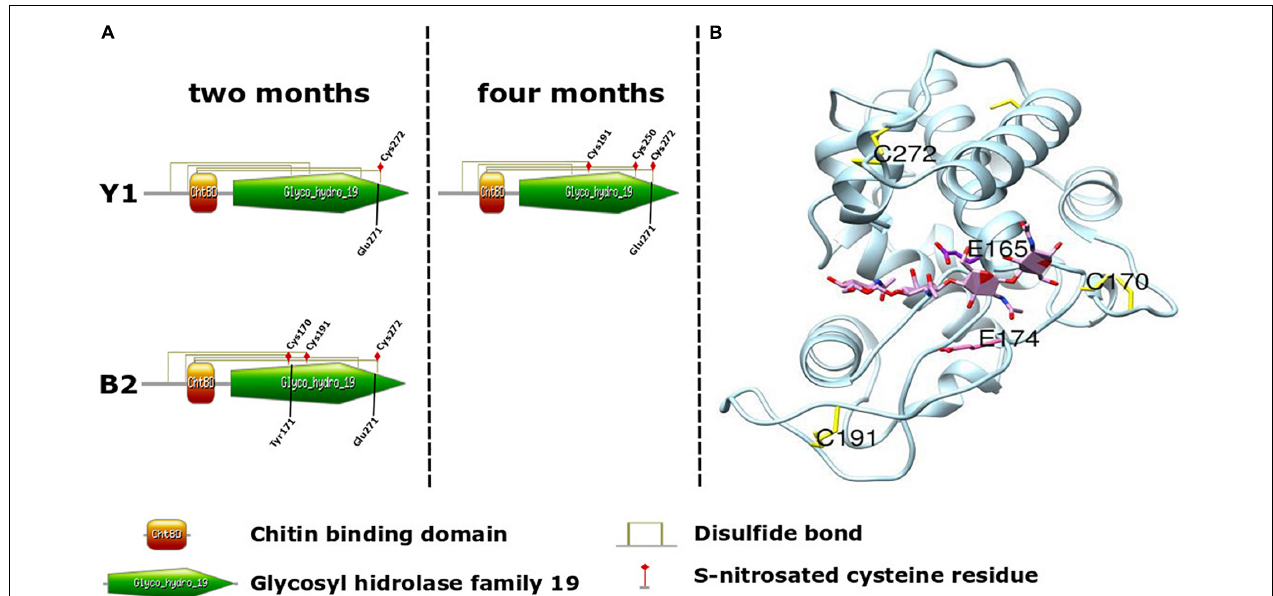
FIGURE 5 | Schematic of Brazilian pine Chitinase IV architecture. (A) Domain organization of Araucaria angustifolia Chitinase IV. Cysteine residues (Cys) identified as undergoing in vivo S-nitrosation during somatic embryo maturation in cell lines Y1 and B2, and involved in the formation of disulfide bond between the Chitin binding domain (orange) and Glycosyl hydrolase family 19 domain (green) are indicated. Tyr171 and Glu271 were identified as enzyme active sites. (B) Three-dimensional structures of the A. angustifolia Chitinase IV modeled using Swiss-model and USCF-Chimera with the crystal structure of Cryptomeria japonica Chitinase IV as template (PDB code: 5H7T). Cysteine residues identified as undergoing in vivo S-nitrosation during somatic embryo maturation in cell line Y1 (C191 and C272) and B2 (C170, C191, and C272) and two catalytic residues E165 and E174 are